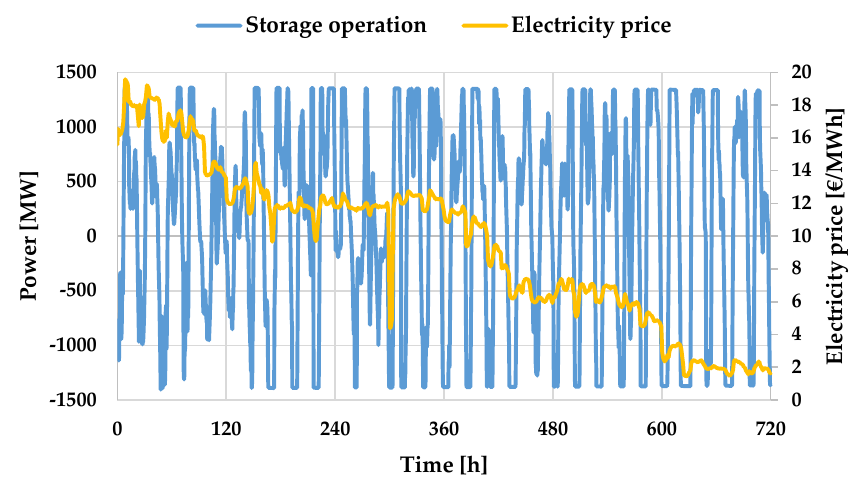
Figure 10. Monthly operation of the storage in the dynamic pricing environment.